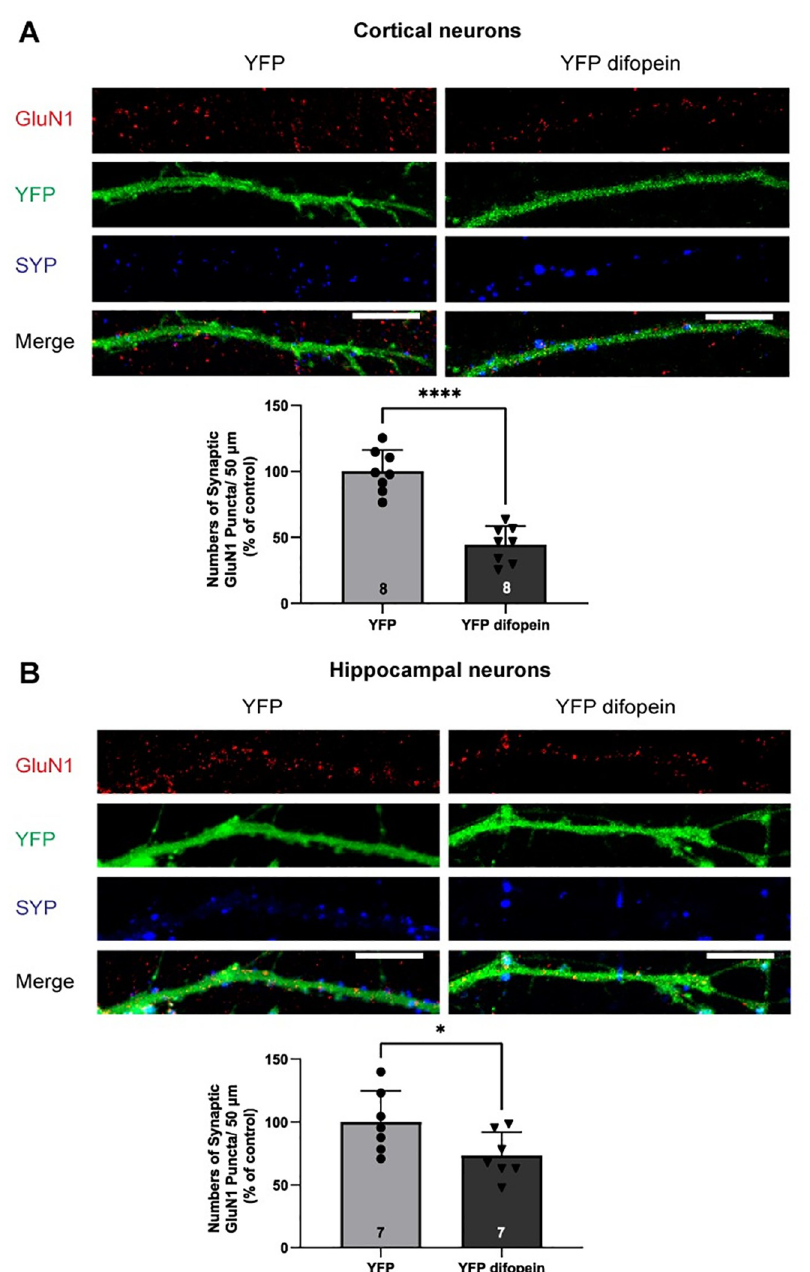
Fig 1. Inhibition of 14-3-3 proteins leads to reduced numbers of synaptic GluN1 puncta in primary glutamatergic cortical and hippocampal neurons. A , Representative images of YFP-difopein or YFP infected cortical neurons labeled with GluN1 (red), YFP (green), and SYP (blue) at DIV21. Bars , Illustrate numbers of synaptic GluN1 puncta/ 50 μ m in YFP-difopein treated glutamatergic cortical neurons normalized to YFP controls (two-tailed unpaired Student’s t -test: ���� p < 0.0001, n = 8). B , Representative images of YFP-difopein or YFP infected hippocampal neurons labeled with GluN1 (red), YFP (green), and SYP (blue) at DIV21. Bars , Illustrate numbers of synaptic GluN1 puncta/50 μ m in YFP-difopein treated glutamatergic hippocampal neurons normalized to YFP controls (two-tailed unpaired Student’s t -test: � p = 0.01413, n = 7). Error bars indicate SD. Scale bar, 10 μ